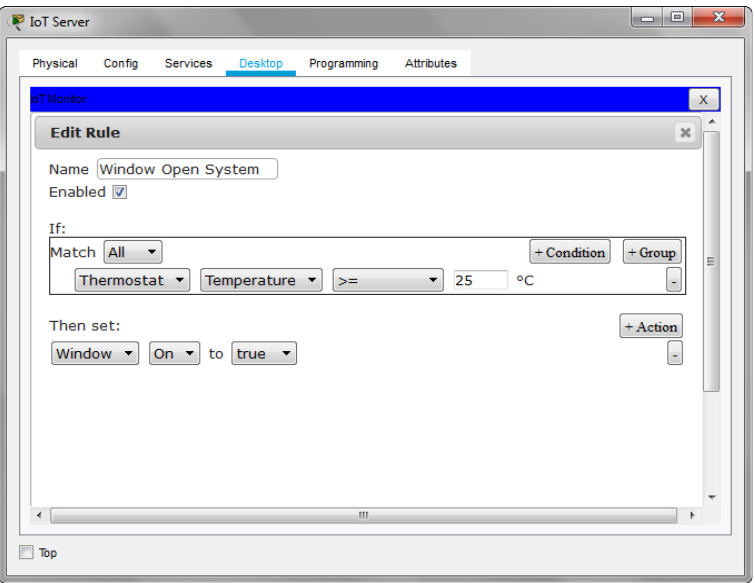
Figure 11. A demonstration on setting condition to control a window-opening system at the IoT